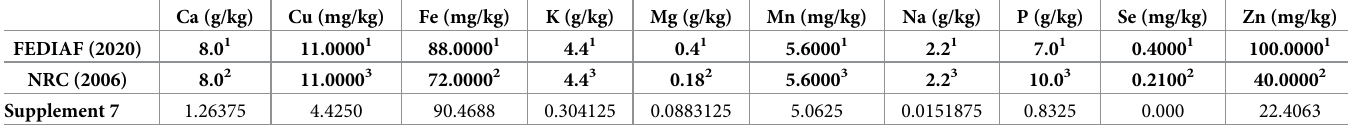
Table 4. Estimate of the concentrations in mg/kg of dry matter of the minerals in the final product (homemade food) from the vitamin-mineral supplement for growing dogs. Ca (g/kg) Cu (mg/kg) Fe (mg/kg) K (g/kg) Mg (g/kg) Mn